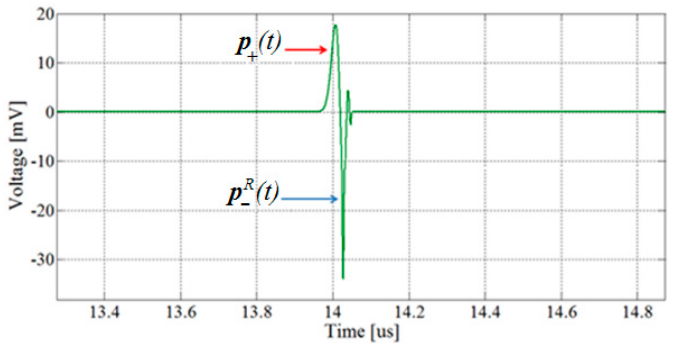
Figure 7. Zoom of simulation result in correspondence of the time in which the negative reflected wave and positive wave are superimposed.